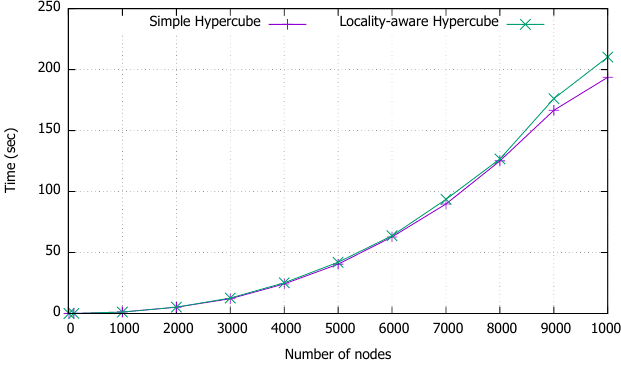
Figure 7. A comparison between the network bootstrapping time for a network with simple Hypercube versus locality-aware Hypercube overlay.